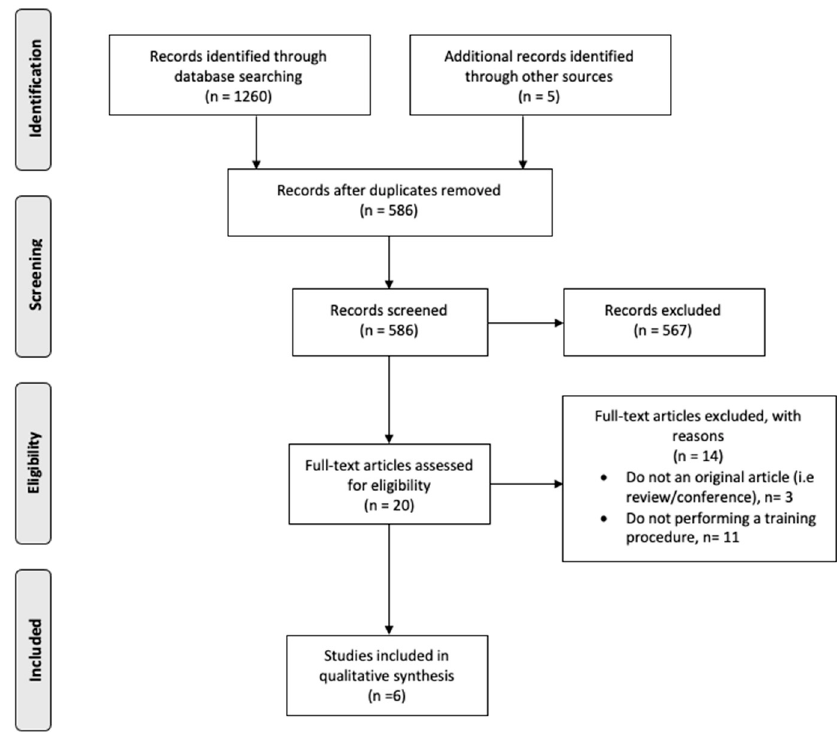
Figure 1. PRISMA flow diagram .